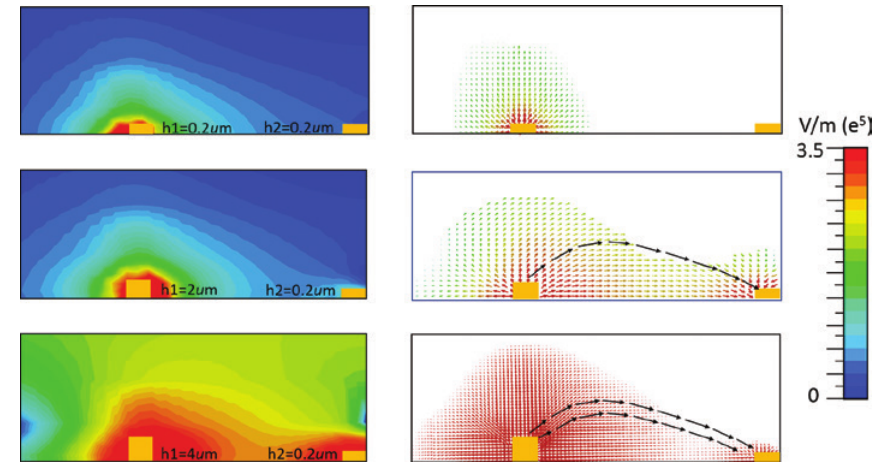
Figure 5: The process of coupled electric field dropping within the undulated